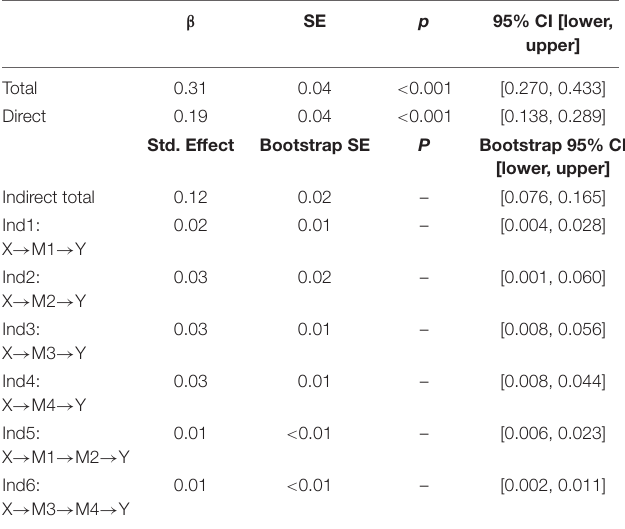
TABLE 2 | Parallel and serial multiple mediation model: Total, direct, and indirect effects between emotional intelligence and self-concept through anxiety, academic performance, social support, and depression. β SE